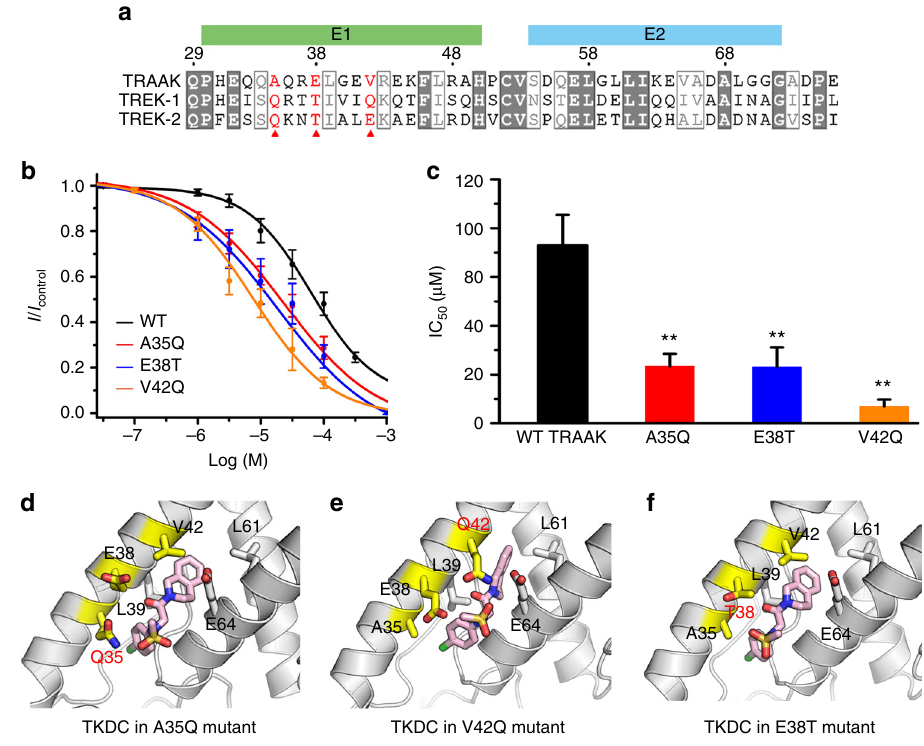
Fig. 3 Substitutions of key residues in the extracellular cap of TRAAK channel. a Multiple sequence alignment for the extracellular caps of TREK-1, TREK-2, and TRAAK channels. b Dose-dependent inhibition of TKDC on the WT and mutant TRAAK channels. c Histograms summarizing the half-inhibitory concentrations of TKDC for the WT ( n = 8), A35Q ( n = 8), E38T ( n = 6) and V42Q ( n = 7) mutant TRAAK channels. Mutations of these residues in the extracellular cap showed enhanced inhibitory effects of TKDC. IC 50 values were obtained via dose – response fi tting. One-way ANOVA with post hoc LSD test was used for statistical analysis [ F (3, 20) = 18.551]; ** indicates P < 0.01. The data are shown as the mean ± s.e.m. d , e Docking modes of TKDC in A35Q TRAAK d , in V42Q TRAAK e , and in E38T TRAAK f . The protein is shown as a cartoon. TKDC and key residues are shown as